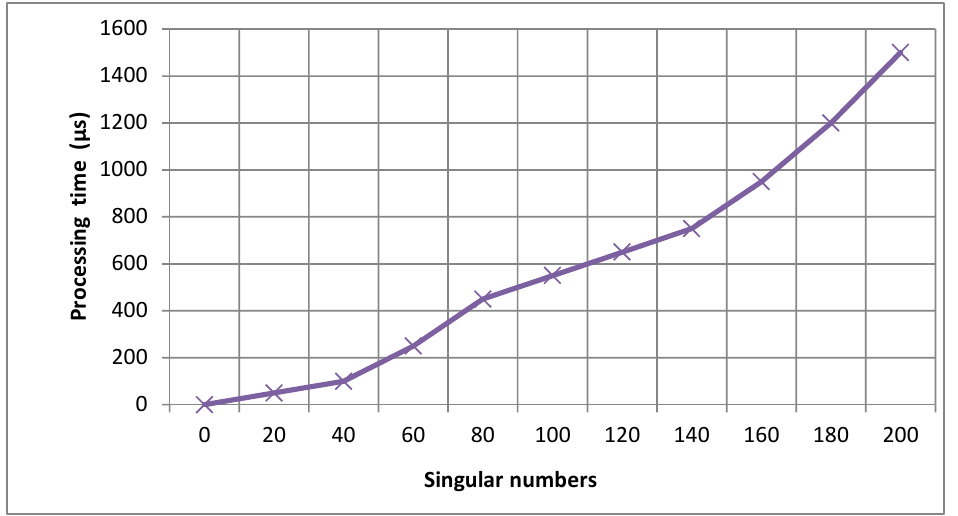
Figure 12. The dependence of the processing time of calculations of the data matrix of rank 200 on the number of singular numbers.